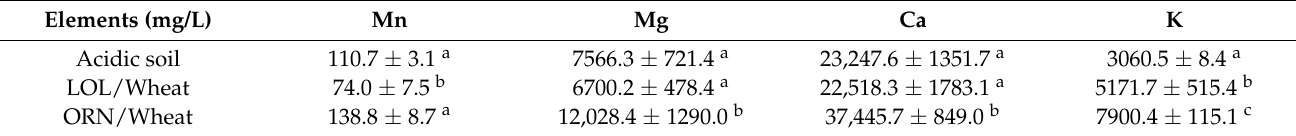
Table 1. Concentrations of Mn, Mg, Ca, and K (mg/L) in the soil solution of standard acidic soil and of acidic soil collected in the vicinity of roots of wheat grown for 3 weeks after the previous development of Lolium rigidum (LOL) or Ornithopus compressus (ORN). Different letters indicate statistically significant differences ( p < 0.05) on the basis of Tukey’s test in each element.